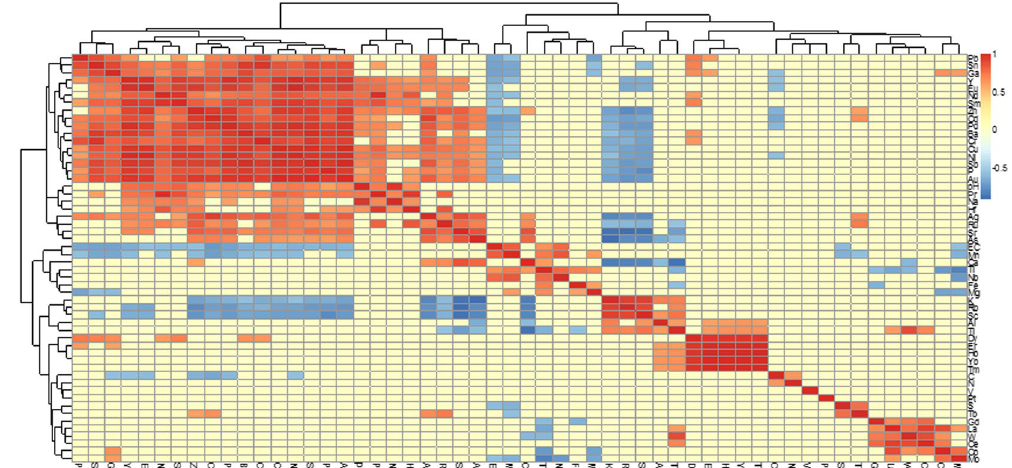
Figure 5. Correlation between elements and environmental